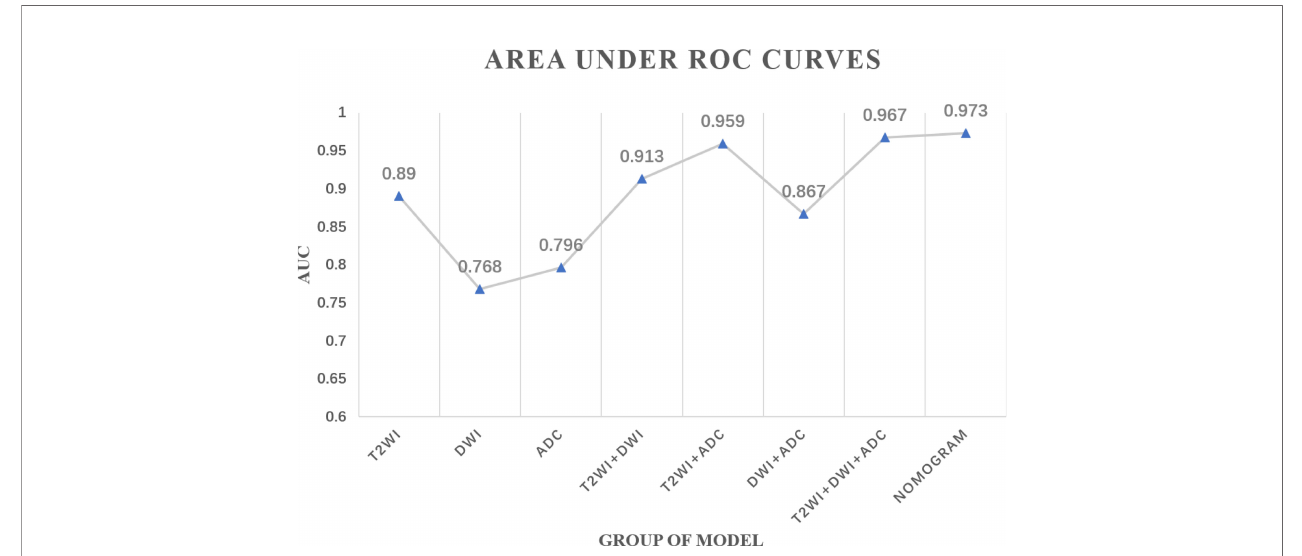
FIGURE 2 | Area under the receiver operating characteristics curves of each radiomics